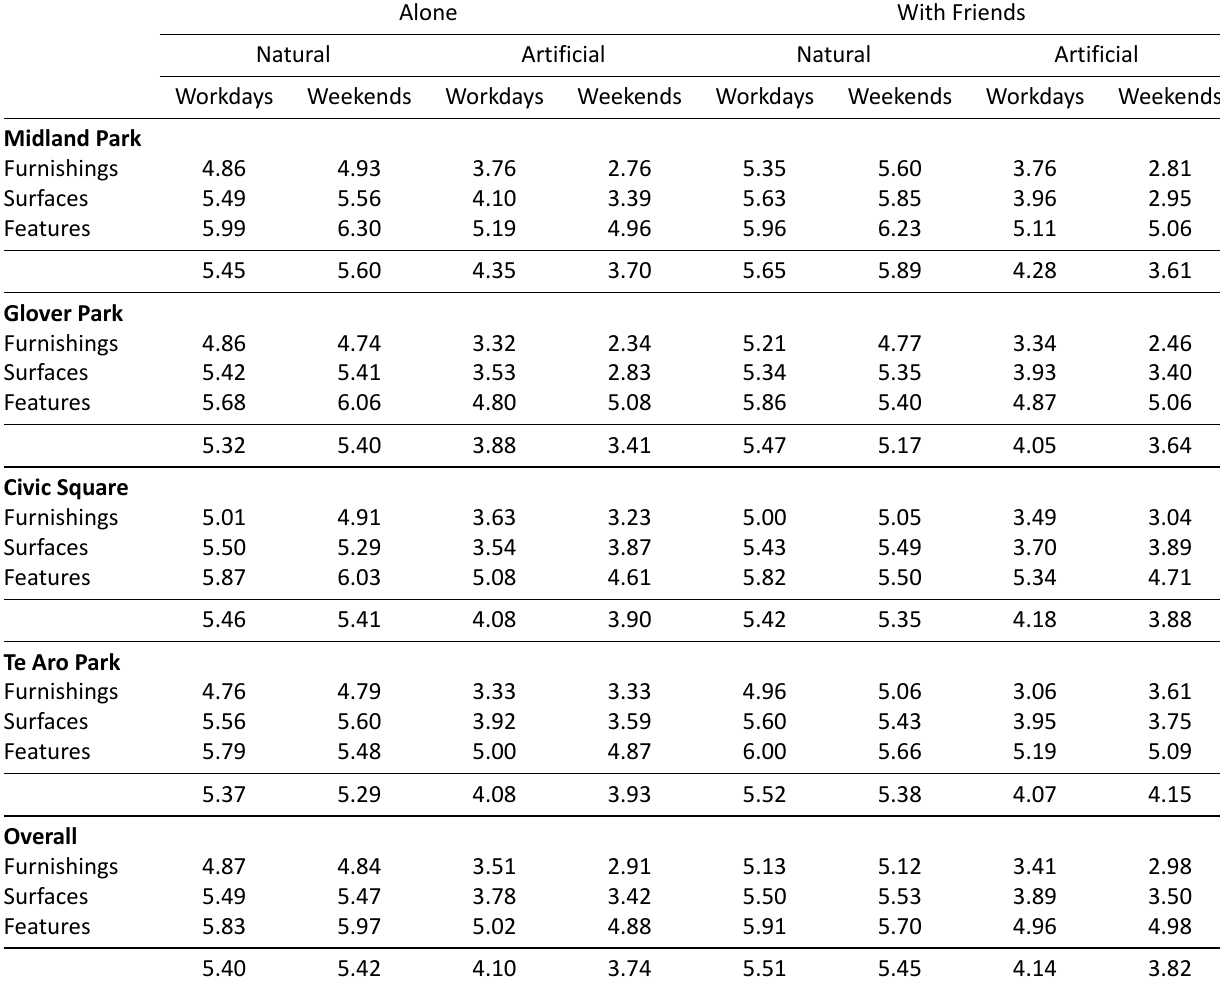
Table 1. Mean preference of natural and artificial design elements.